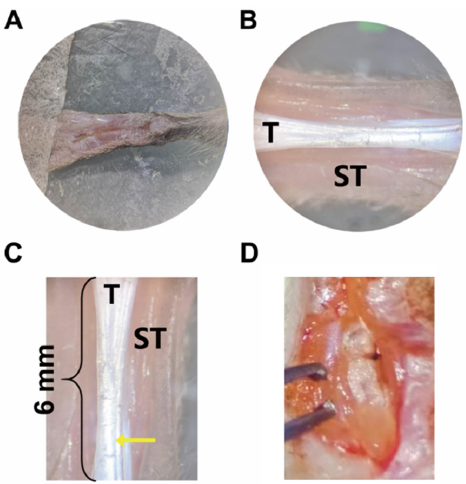
Figure A1. The processing of longitudinal incision model . T: tendon, ST: surround tissue. Yellow arrow shows the incision. ( A – C ) To make the LCM, the flexor digitorum longus (FDL) tendon in the right hind-paw was surgically exposed through a posterior midline incision. The FDL tendon was then cut along three 6 mm longitudinal plantar incisions. ( A ) is enlarged 4 times under the microscope. ( B ) is enlarged 8 times and ( C ) is enlarged 10 times, which are both the same figure. But ( C ) was marked with the incision (yellow arrow). ( D ) To create the TRM, the FDL tendon was transected and repaired using a Kessler suture in the right hind-paw. ( D ) is enlarged 8 times.